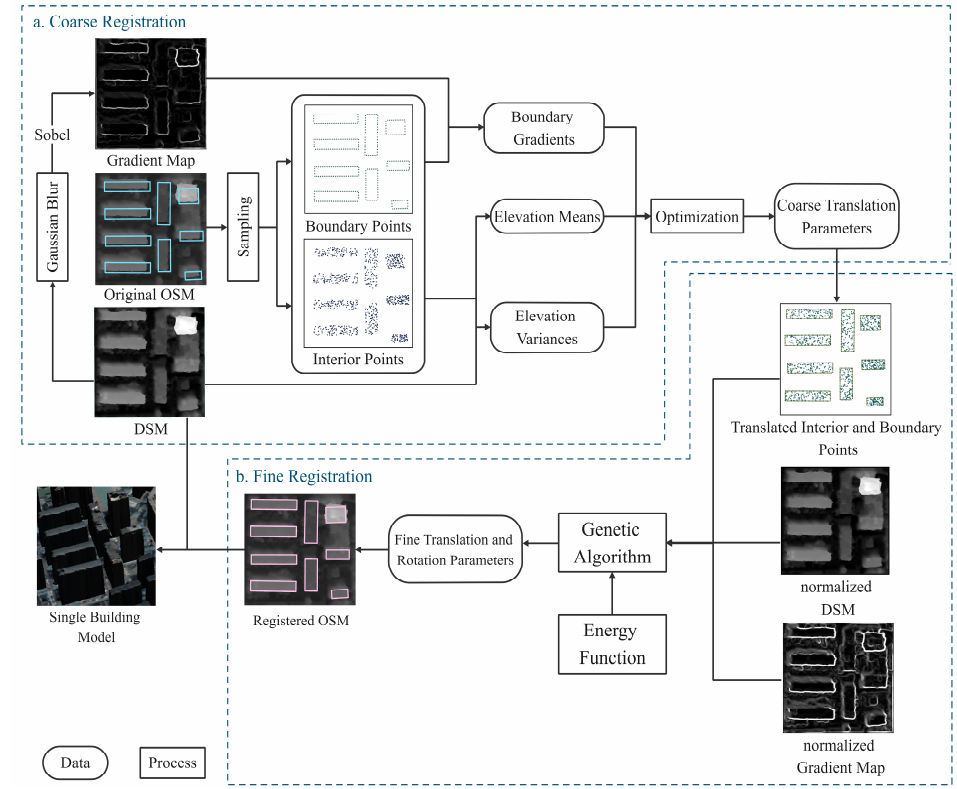
Figure 1. An overview of our proposed method. In ( a ) “coarse registration” step, taking DSM, OSM, and the gradient map as input, this paper computed coarse translation parameters by optimization. In ( b ) “fine registration” step, the optimal translation and rotation parameters are computed based on an energy function and genetic algorithm. Single building model was reconstructed by clipping DSM with registered OSM.